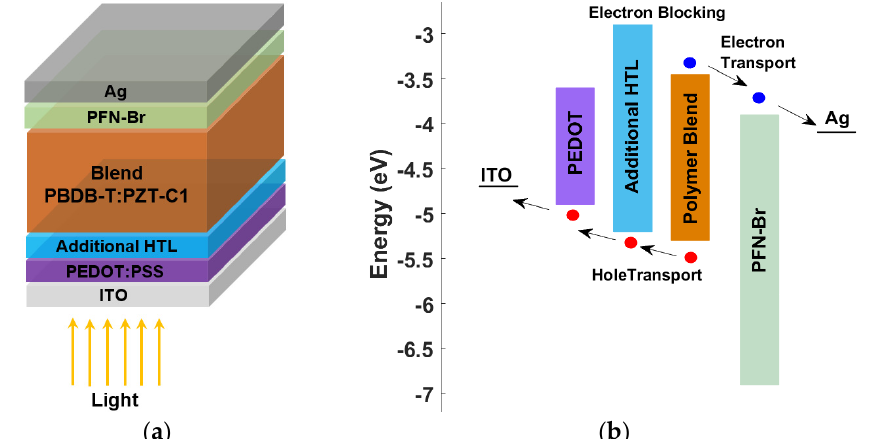
Figure 6. Proposed all-polymer-based solar cell structure: ( a ) basic layers, ( b ) energy band profile before contact.